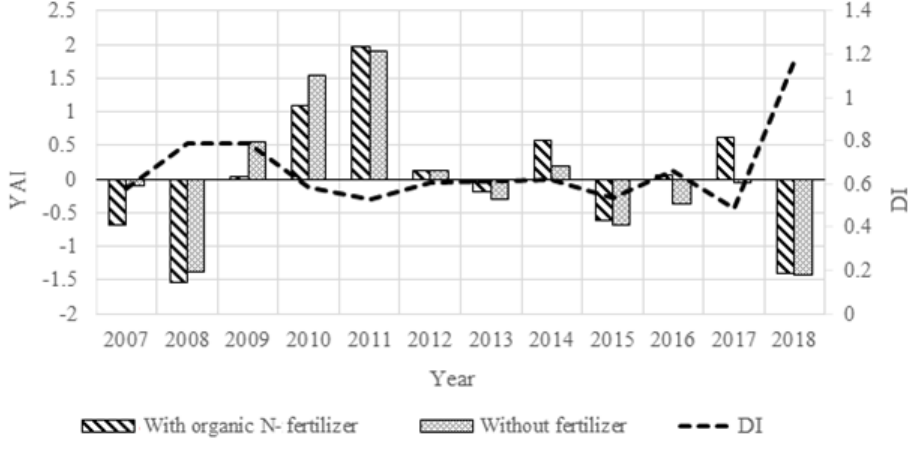
Figure 10. Time series of yield anomaly index (YAI) and DI for a selected time period (2007–2018).